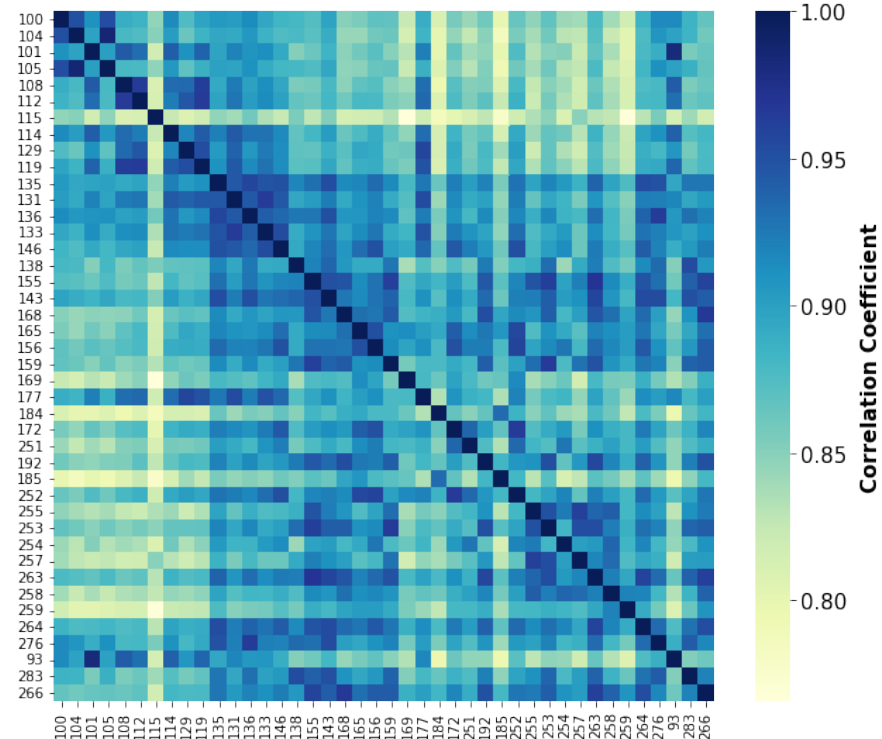
Figure A1. A heat map for Pearson correlation coefficients between historical solar irradiance (January 2017–December 2019) of the ASOS stations. The darker colors indicate that solar irradiance of two ASOS stations were more correlated with each other.